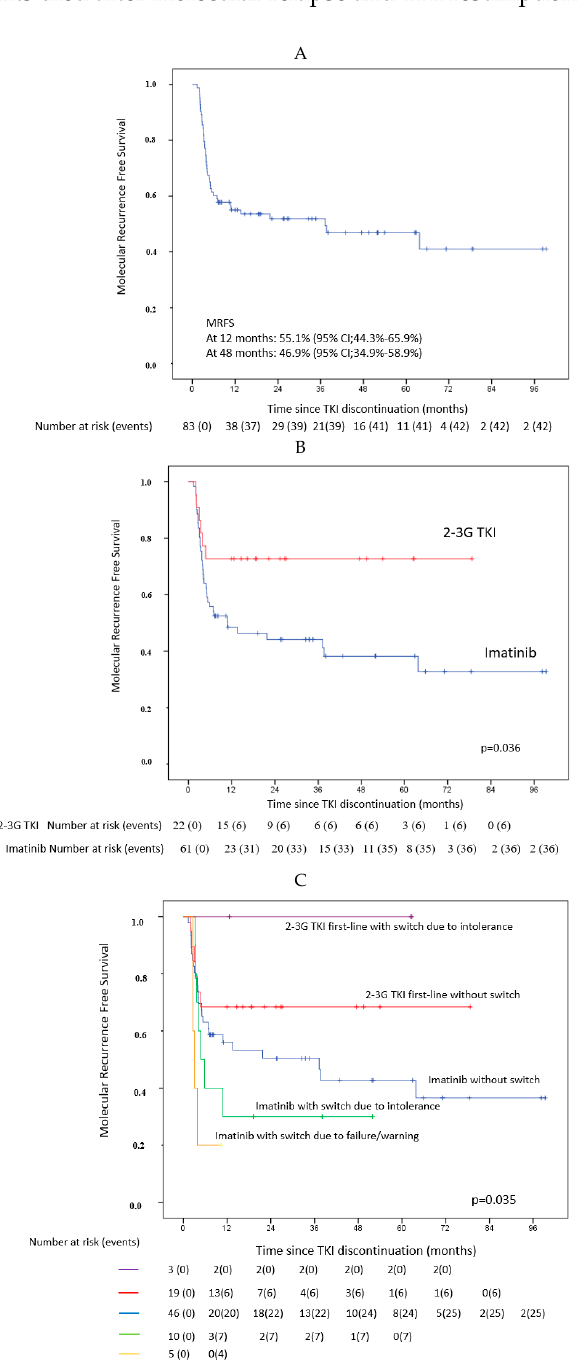
Figure 3. Molecular Recurrence-free survival (MRFS) (N = 83 pts). (A): all patients, (B): according to first-line TKI (Imatinib vs. 2nd or 3rd generation TKI), (C): according to first-line TKIs (Imatinib vs. 2nd or 3rd generation TKI) and history of switch for intolerance or insufficient efficacy (failure or warning as defined in the 2013 ELN recommendations [26]).